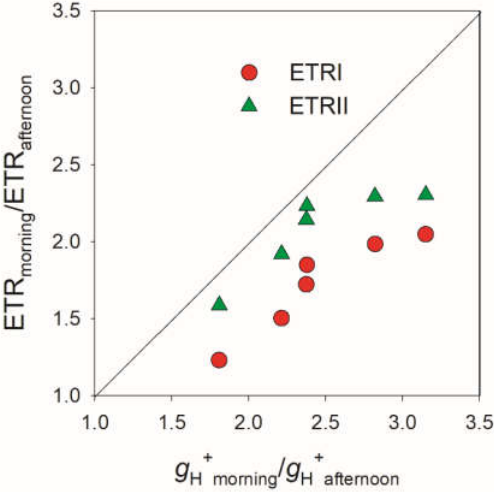
Figure 6. Changes in the decrease amplitudes of ETRI and ETRII in the afternoon as a function of the decrease amplitude of g H+ for leaves of Vanilla planifolia . Light response data from Figures 3 and 4 were used to calculate the decrease amplitudes of ETRI, ETRII, and g H+ in the afternoon when compared with those in the morning.